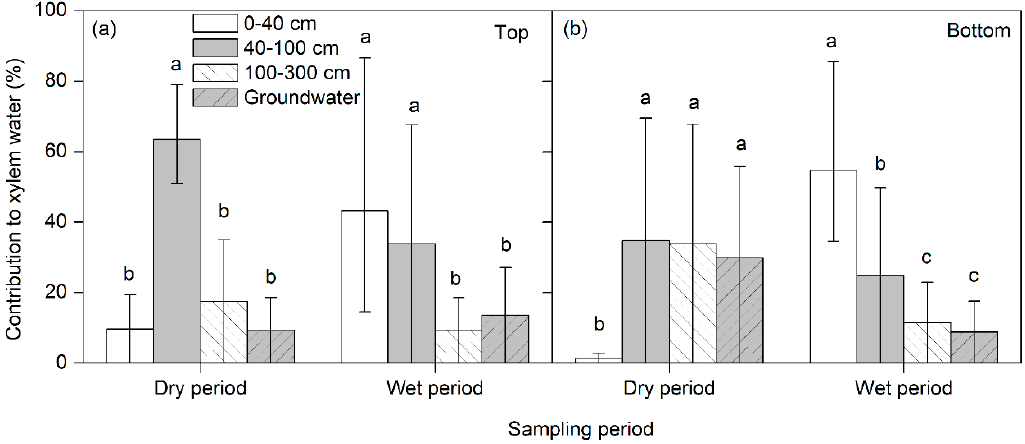
Figure 5. Percentage contribution of potential water sources during the dry and wet periods for Mongolian pine growing on the top ( a ) and bottom ( b ) of the sand dunes. Column heights represent the mean value of relative contributions and bars represent the ranges of minimum and maximum, both were calculated using the IsoSource model [44]. Different letters indicated significant differences among the potential water sources in the same sampling period on the same topographic position ( n = 4).